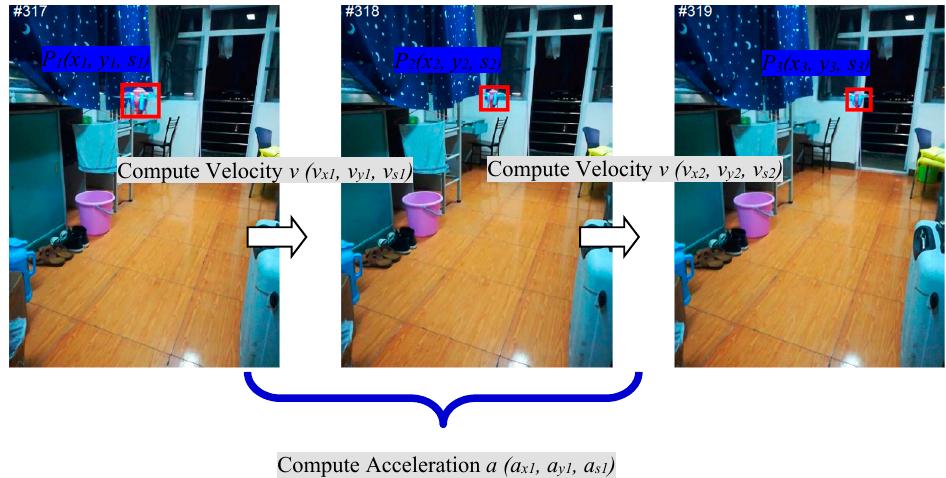
Figure 2. Illustrating of instantaneous motion estimation on the test sequence of UAV.